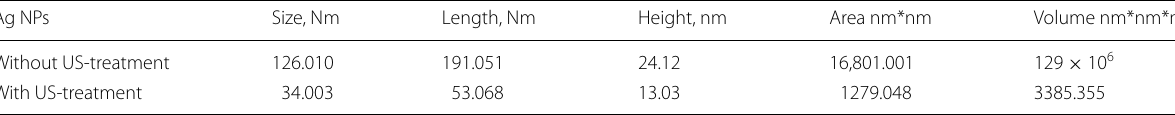
5%) parameters of GS Ag NPs with and without US-treatment ±